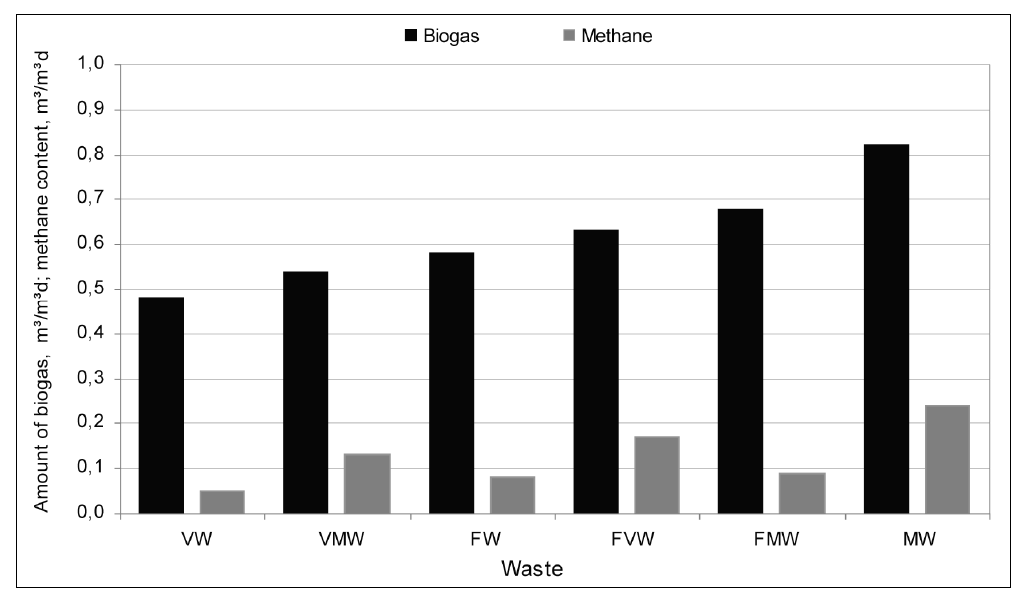
3 3 3 3 /m d) and methane (m /m d) anaerobic digestion of biodegradable waste under